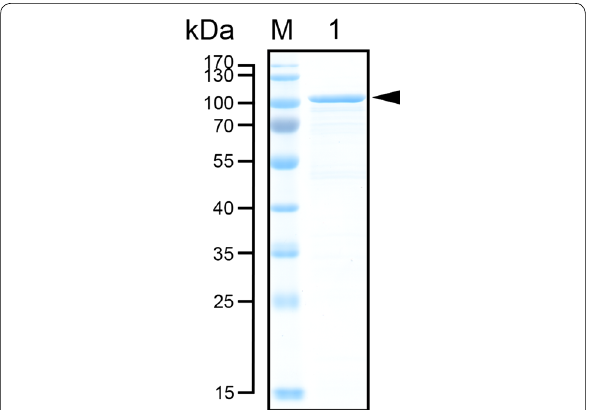
Fig. 2 SDS‑PAGE analysis of purified rAgaB‑4. Lane M PageRuler ™ Prestained Protein Ladder; lane 1 purified rAgaB‑4